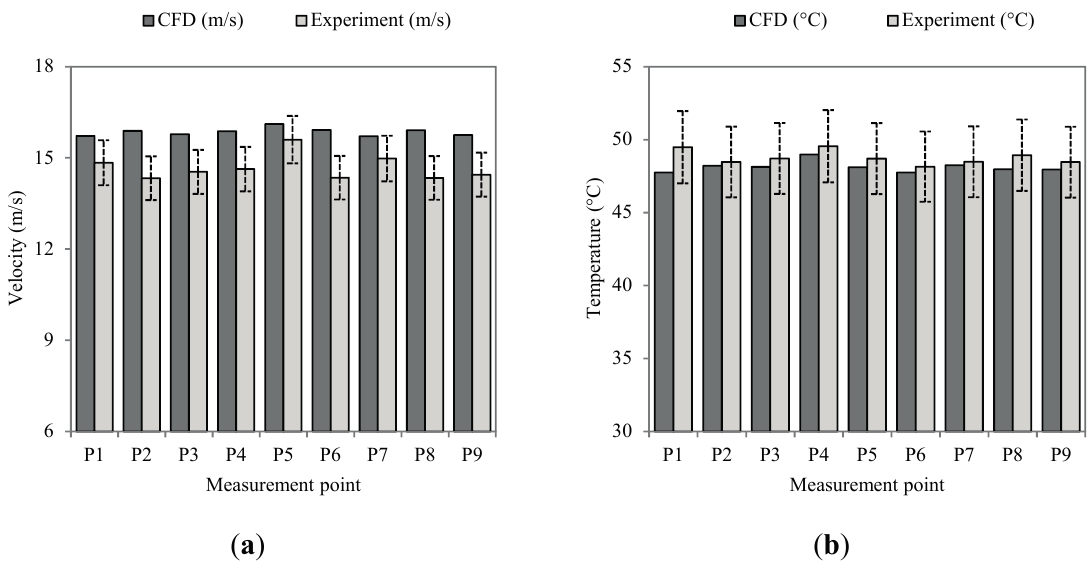
Figure 14. Comparison between Computational Fluid Dynamics (CFD) and experimentally obtained ( a ) air velocities and ( b )